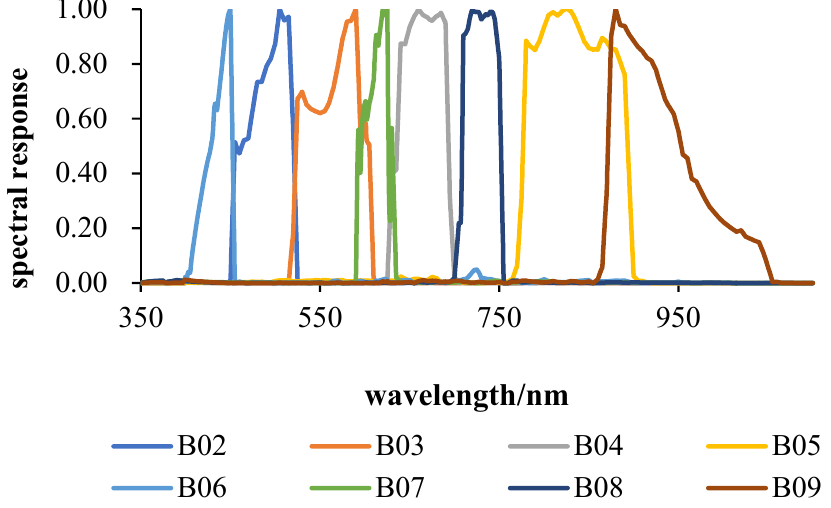
Figure 1. Spectral response function of multispectral sensor.